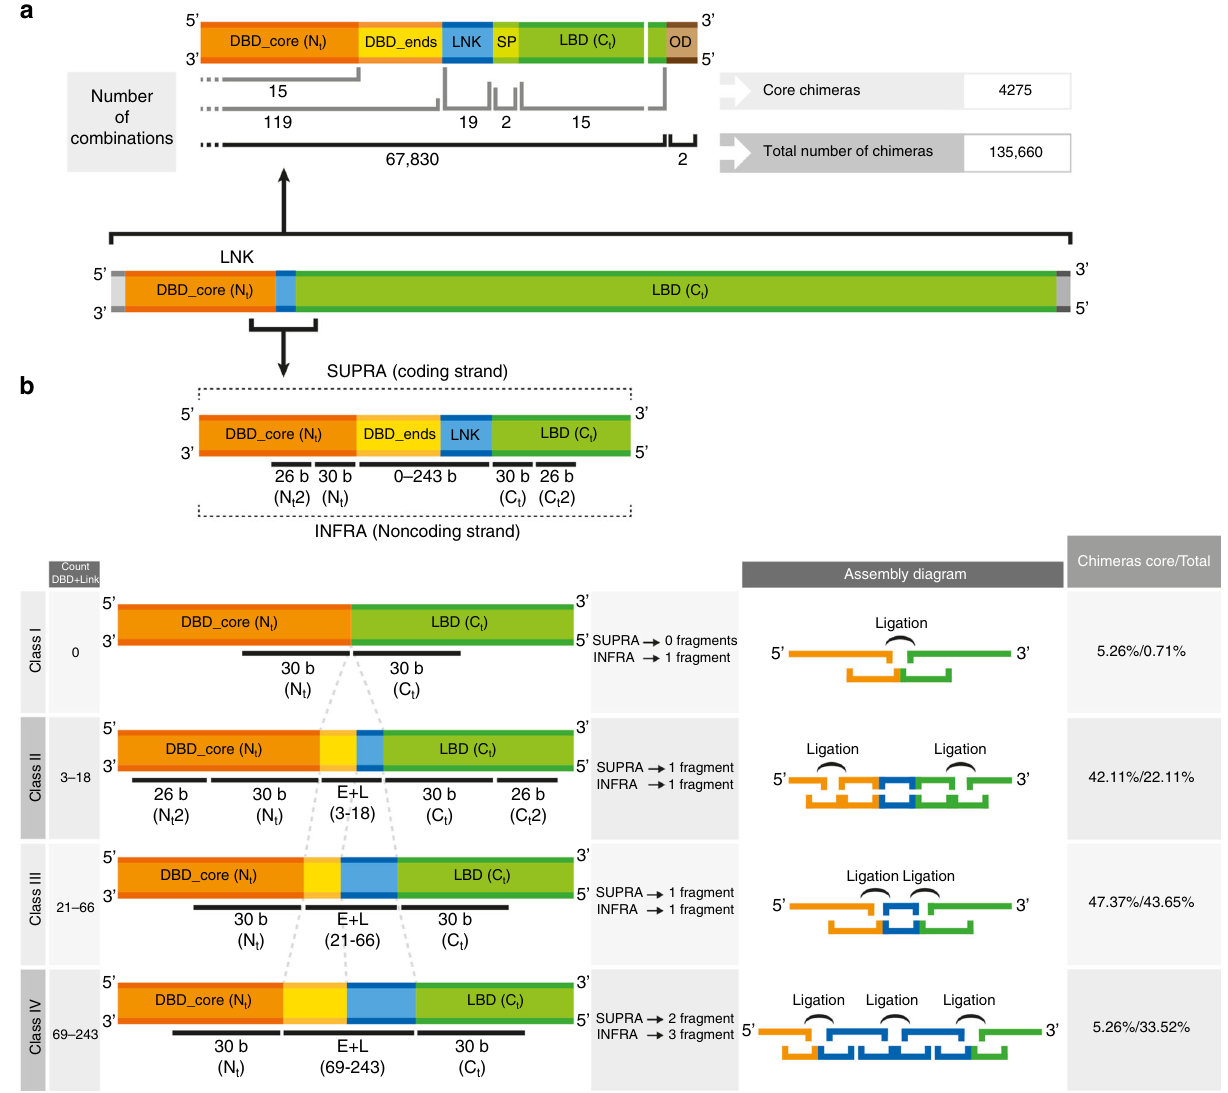
Fig. 2 Domain structure of chimeric TFs and complexity-dependent classi fi cation for eLCR. Representation of an average chimera maintaining the proportion between the lengths of the different regions that integrate it. DBD-CORE are represented in orange, ENDS are represented in dark yellow, LNK in blue, signal peptides (SP) in light green, LBD in dark green, and OD in brown. a Not-to-scale representation of the joint between DBDs and LBDs together with OD. The number of domains of each kind incorporated into the assembly scheme as well as the maximum number of chimeras resulting from the eLCR are also represented. b Zoomed in simpli fi ed version of the joint between DBDs and LBDs. ENDS and LNKs occupy the center of the representation, as they were the regions incorporated in the eLCR through a collection of oligonucleotides. DBDs and LBDs (with and without SP) were introduced in the assembly as dsDNA fragments. The numbers below the different domains represent the number of DNA bases included into the oligonucleotides in the DNA microarray synthesis. The panel below represents the number of bases corresponding to each one of the domain types that needed to be introduced into the eLCR oligonucleotides depending on the assembly Class the chimera was assigned to. The Assembly Diagram represents, in the same color code that above, the fi nal Supra and Infra oligonucleotides and the ligation events that needed to take place to reconstitute the fi nal chimera. Finally, the percentage of “ CORE ” and total chimeras assigned to each one of the Classes, in the library design, is included on the right side of Panel